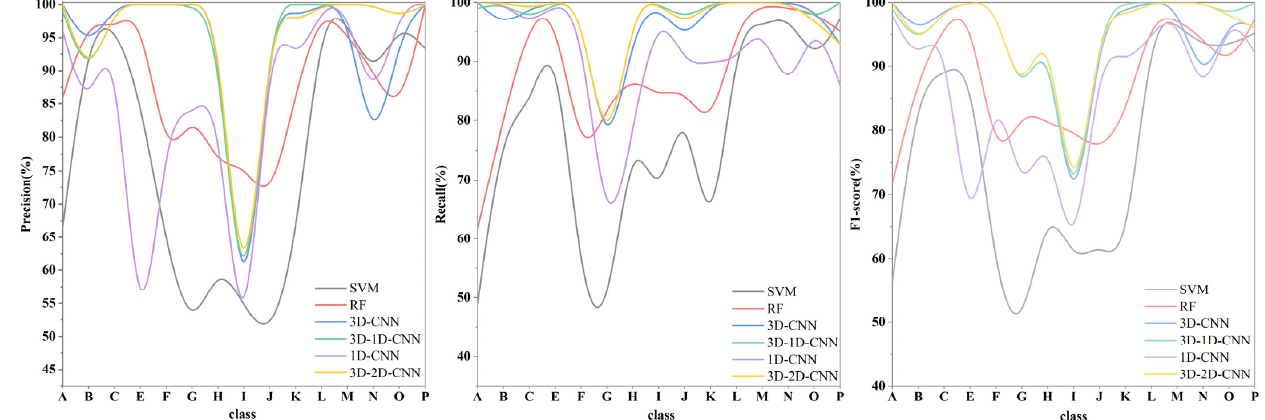
Figure 8. Recall, Precision, and F1-score of each class in different classifiers on the Houston dataset, where A, B, C, D, E, F, G, H, I, J, K, L, M, N, O, represent commercial, grass_healthy, grass_stressed, grass_synthetic, highway, parking_lot1, parking_lot2, railway, residential, road, running_track, soil, tennis_court, tree, water, respectively.